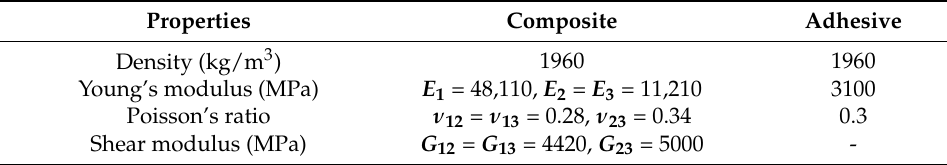
Table 1. Composite and adhesive mechanical properties.